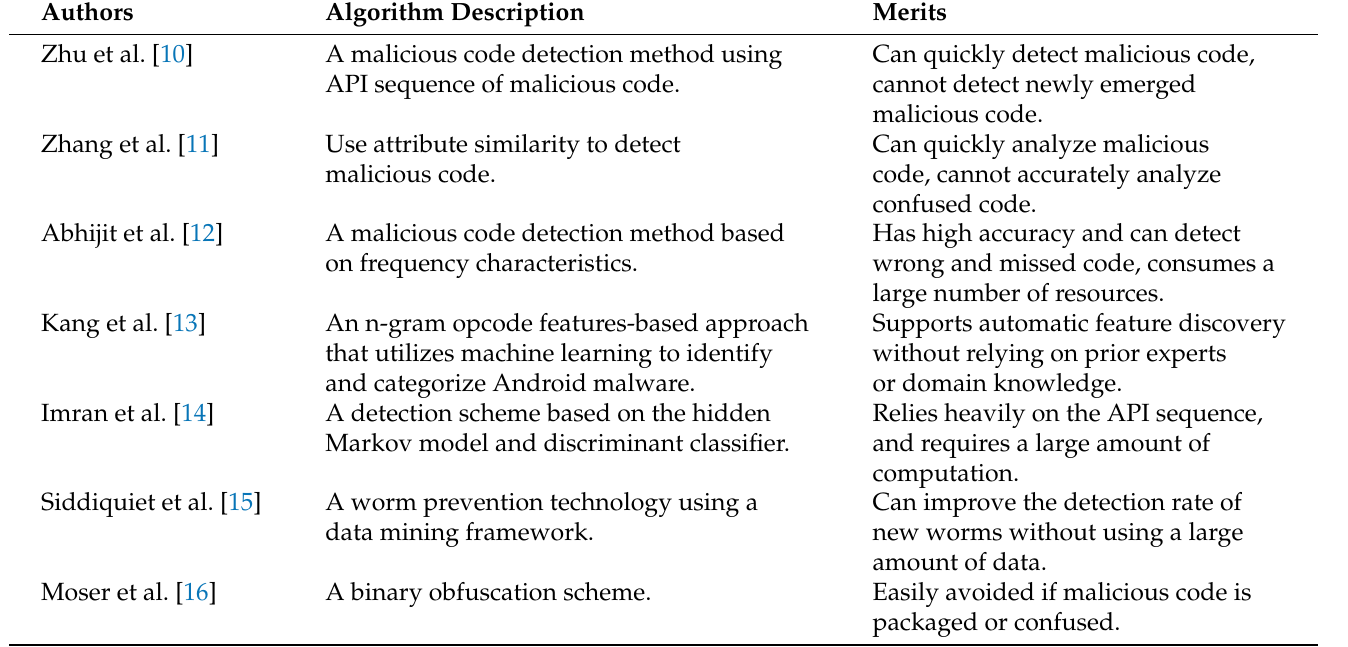
Table 1. The static detection